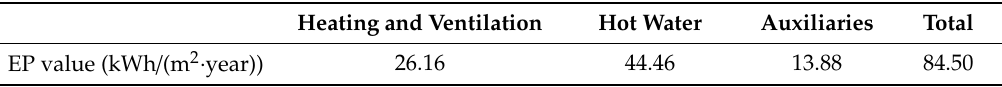
Table 5. The annual final energy demand EK (kWh / (m 2 · year)) for the multi-family building at Barnima Street in Stargard. Energy Carrier Heating and Ventilation Hot Water Auxiliaries Total District heating ( w = 0.92) 28.44 48.33 0.00 98.65 Mains electricity ( w = 3.0) 0.00 Table 6. The annual primary energy demand EP (kWh / (m 2 · year)) for the multi-family building at Barnima Street in Stargard. Heating and Ventilation Hot Water Auxiliaries Total